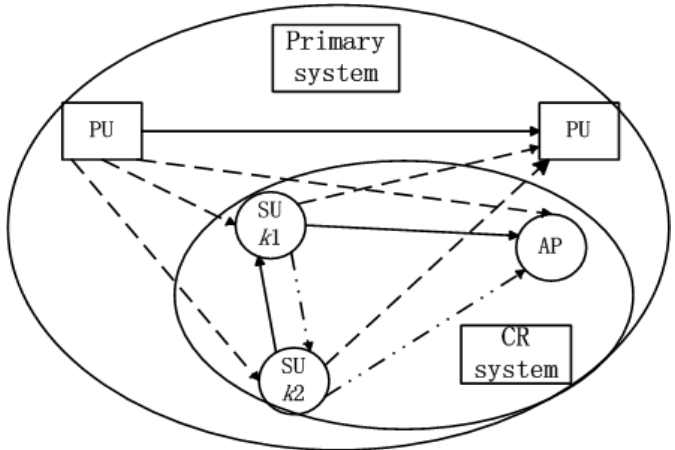
Figure 1. A cooperative MU-OFDM CR uplink